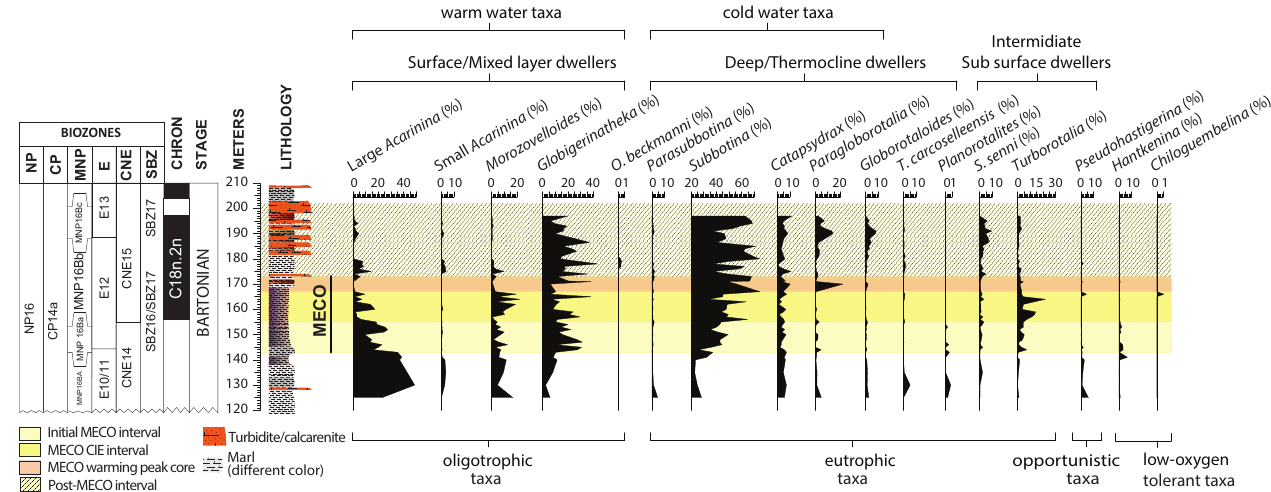
Figure 5. Relative abundance of middle Eocene planktic foraminiferal genera and selected species form the Baskil section. The main ecological preferences are also indicated (see text for explanations). Magneto-biostratigraphy and lithostratigraphy as in Figure